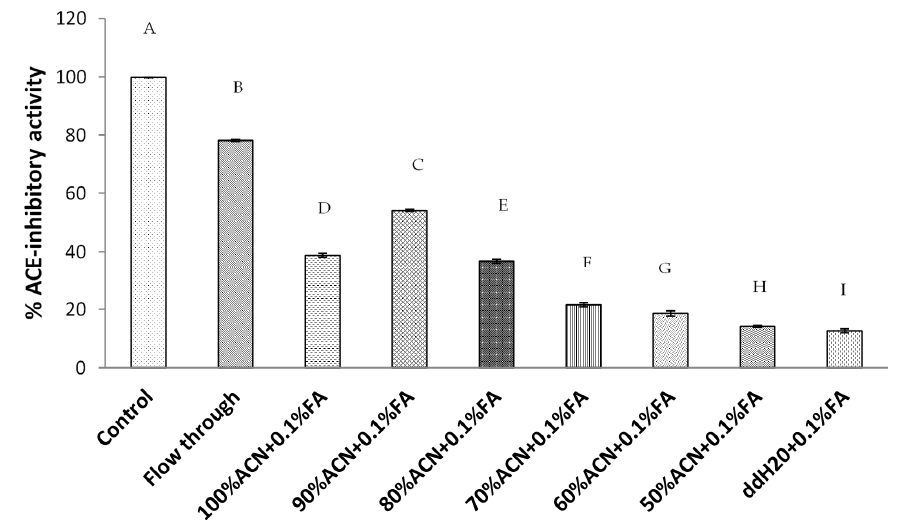
Figure 2. ACE inhibitory activities of different HILIC fractions derived from GSPs hydrolysate (<3 kD). These HILIC fractions include flow-through (FT), 100%, 90%, 80%, 70%, 60%, and 50% ACN containing 0.1% FA. Means denoted by a different letter indicate significant differences between treatments ( p < 0.05).